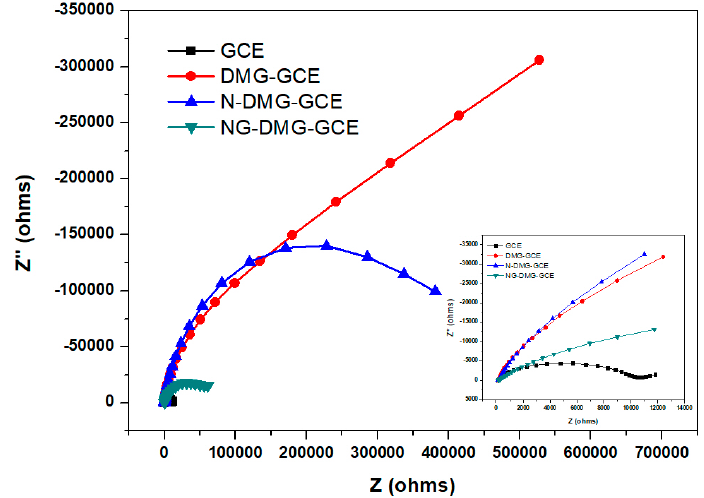
Figure 9. Nyquist plots at GCE (black); DMG-GCE (red); N-DMG-GCE (blue) and NGr-DMG-GCE (green) in 5 mM Fe(CN) 63 − /4 − containing 1 M KCl. Inset is the magnified Nyquist plot between 0 and (green) in 5 mM Fe(CN) 63 − /4 − containing 1 M KCl. Inset is the magnified Nyquist plot between 0 and 12 k Ω . The frequency range is between 0.1 and 100,000 12 k Ω . The frequency range is between 0.1 and 100,000 Hz.